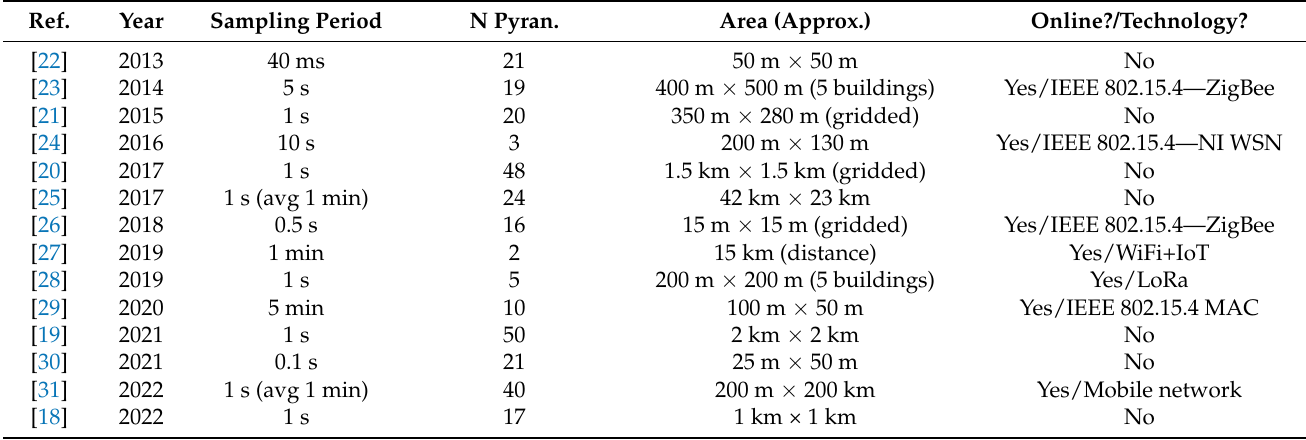
Table 1. Irradiance sensor